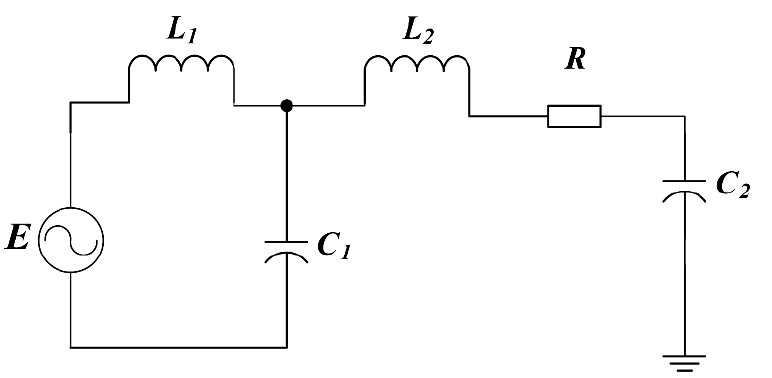
Figure 7. Mode transition in one switching cycle.